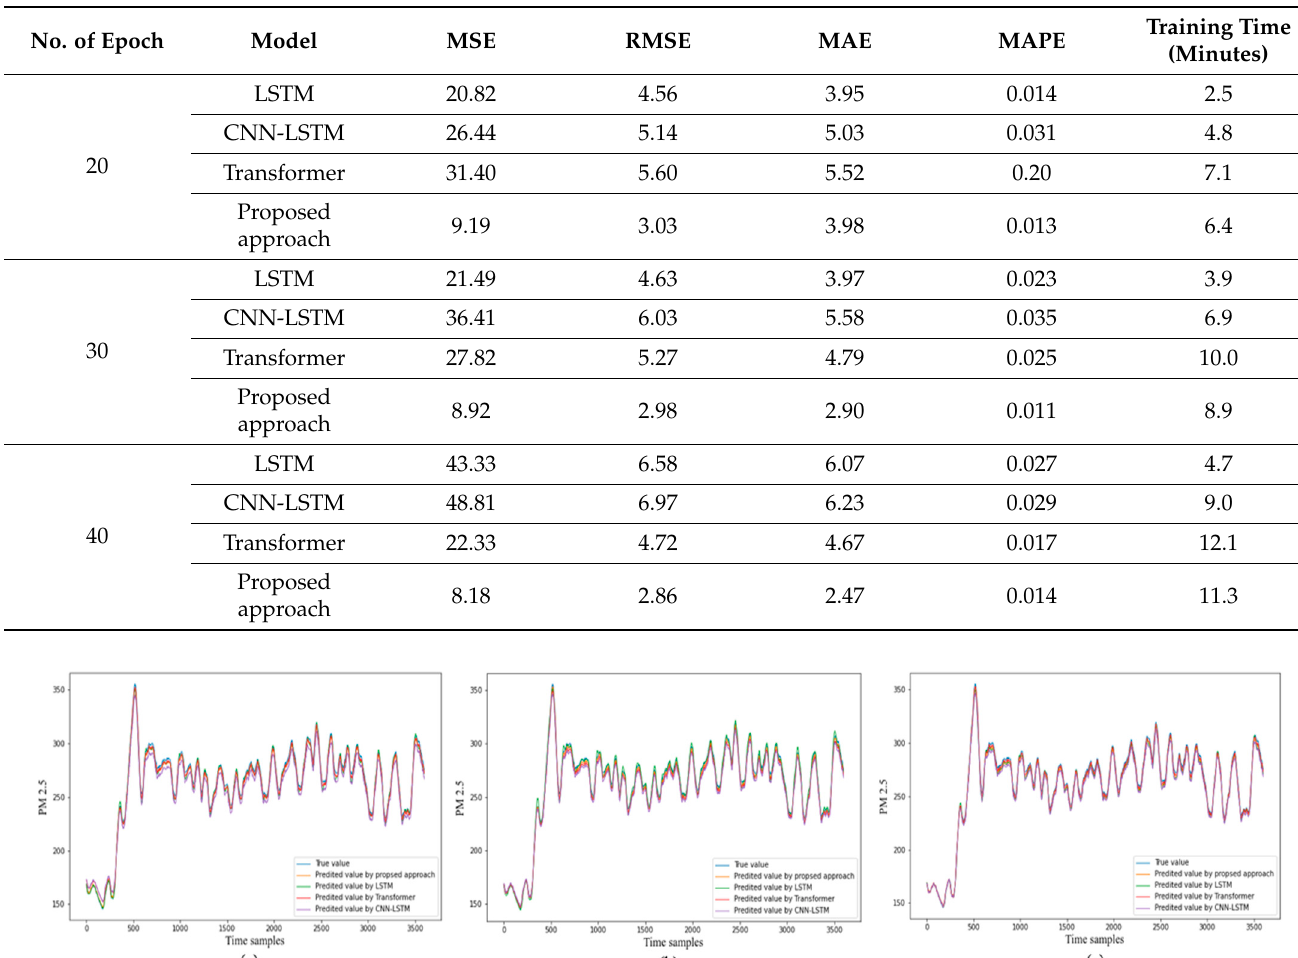
Table 4. The 1 h ahead forecasting performance of LSTM, CNN-LSTM, Transformer models, and our proposed approach (Single-Dense Layer BiLSTM).